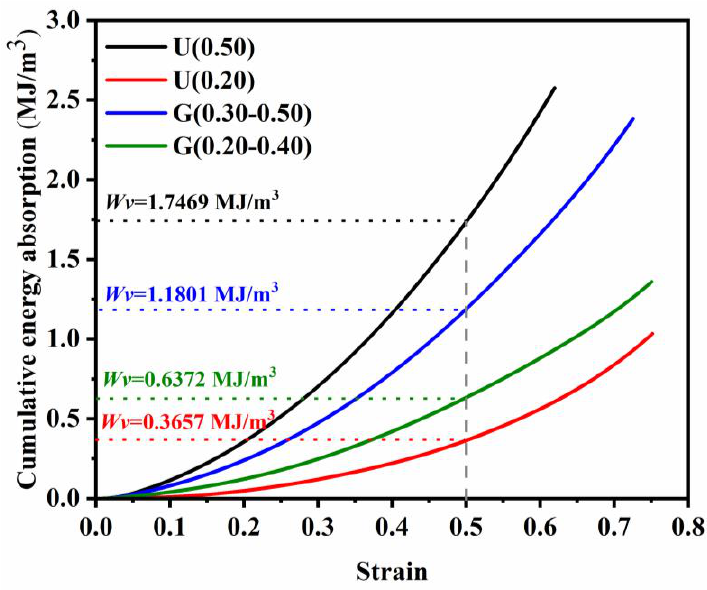
Figure 12. Cumulative energy absorption for different lattice structures.